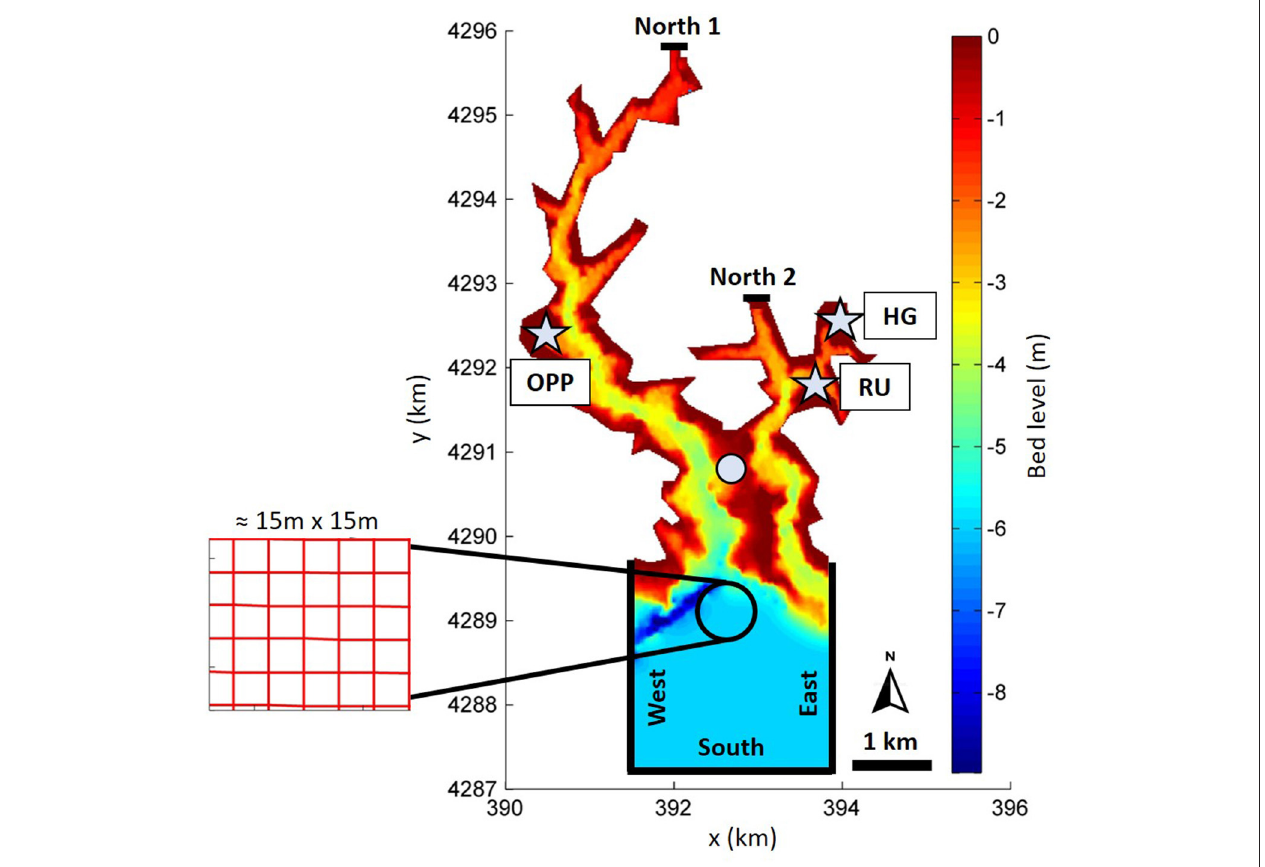
FIGURE 2 | The Broad Creek numerical domain. Model bathymetry with the location of boundary conditions and deposition sites (stars). The white circle denotes the point at which water levels were